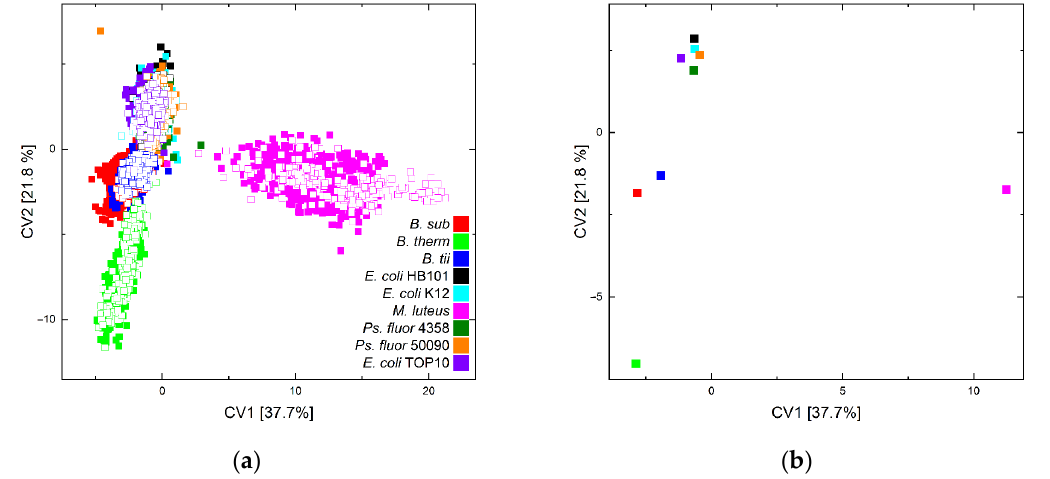
Figure 3. Scatter plots of canonical variable 1 vs. 2 of the QDA of all training data (solid squares) and the independent test data (unfilled squares) of all microorganisms and sampling or lifetime conditions ( a ) and of the group centroids of the training data ( b ).